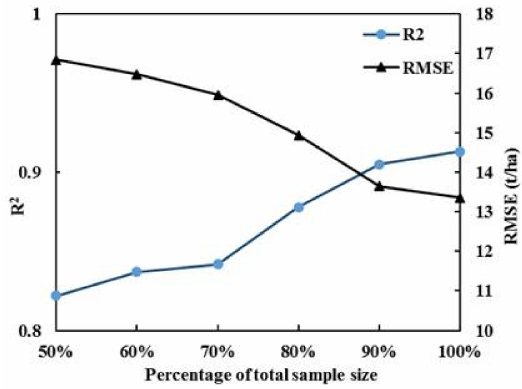
Figure 7. Accuracies of the RF AGB models estimated by different sample